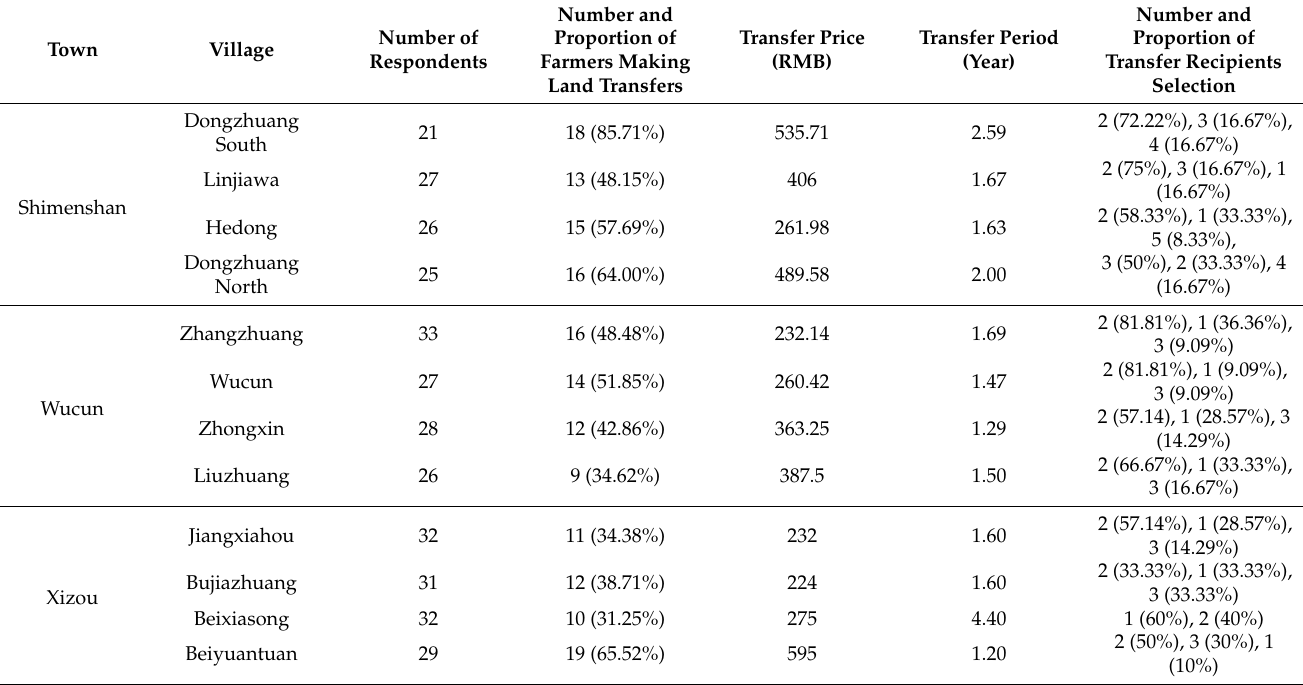
Table 2. Land transfer features of